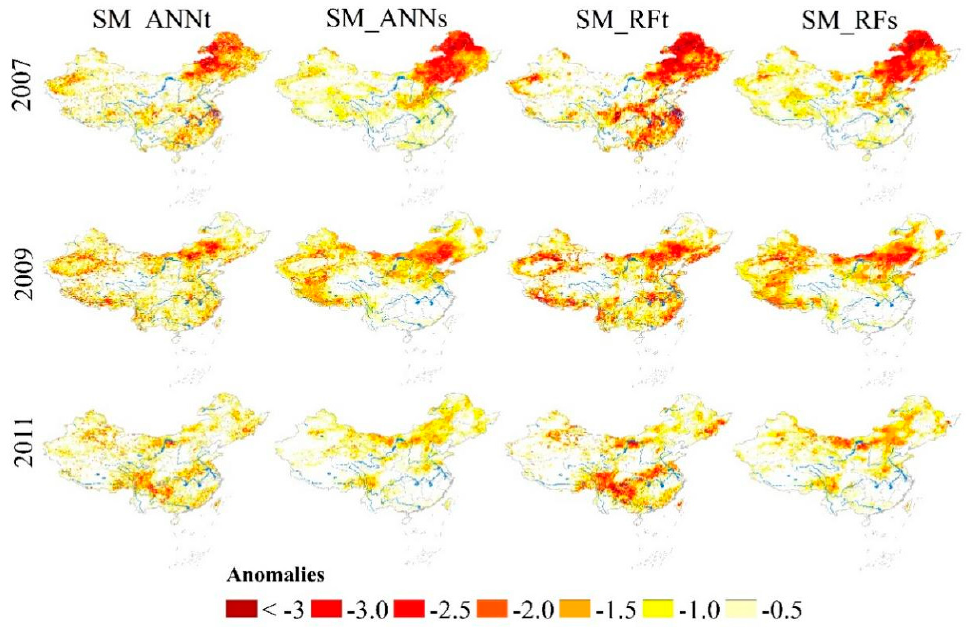
Figure 11. Spatial distribution of average anomalies of reconstructed soil moisture in the temporal and domains with the ANN and RF models (denoted as SM_ANNt, SM_ANNs, SM_RFt, and SM_RFs) in 2007, 2009, and 2011, respectively.